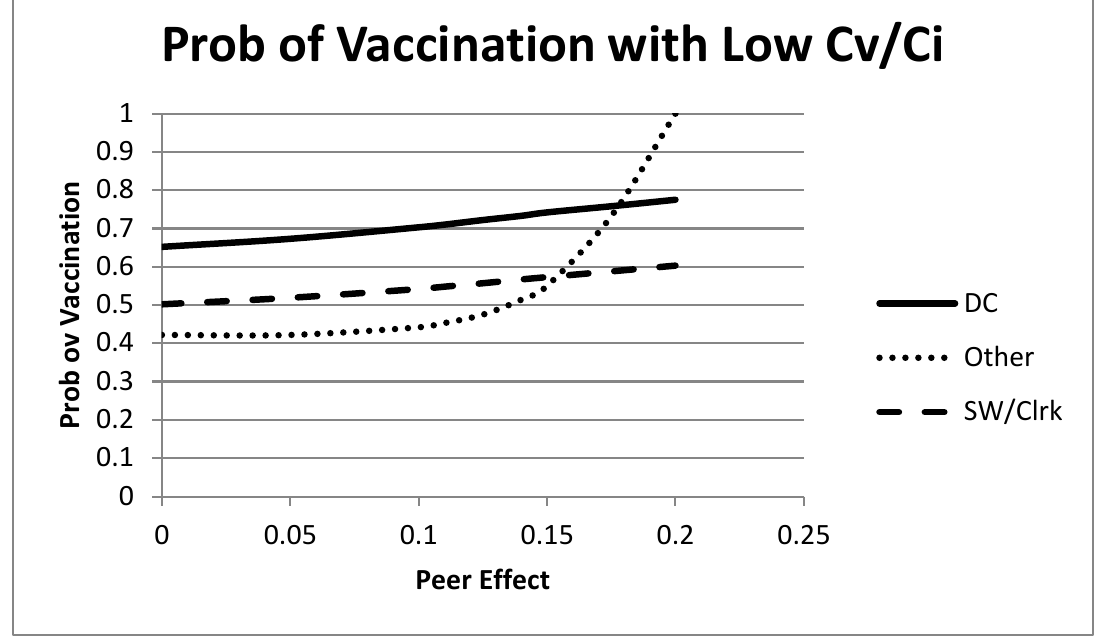
Figure 3. Mixed strategy equilibrium vaccination choices as a function of the size of the peer effects. In this figure, λ is small, λ = 0 . 05 . All groups increase their equilibrium vaccination rate as peer effects